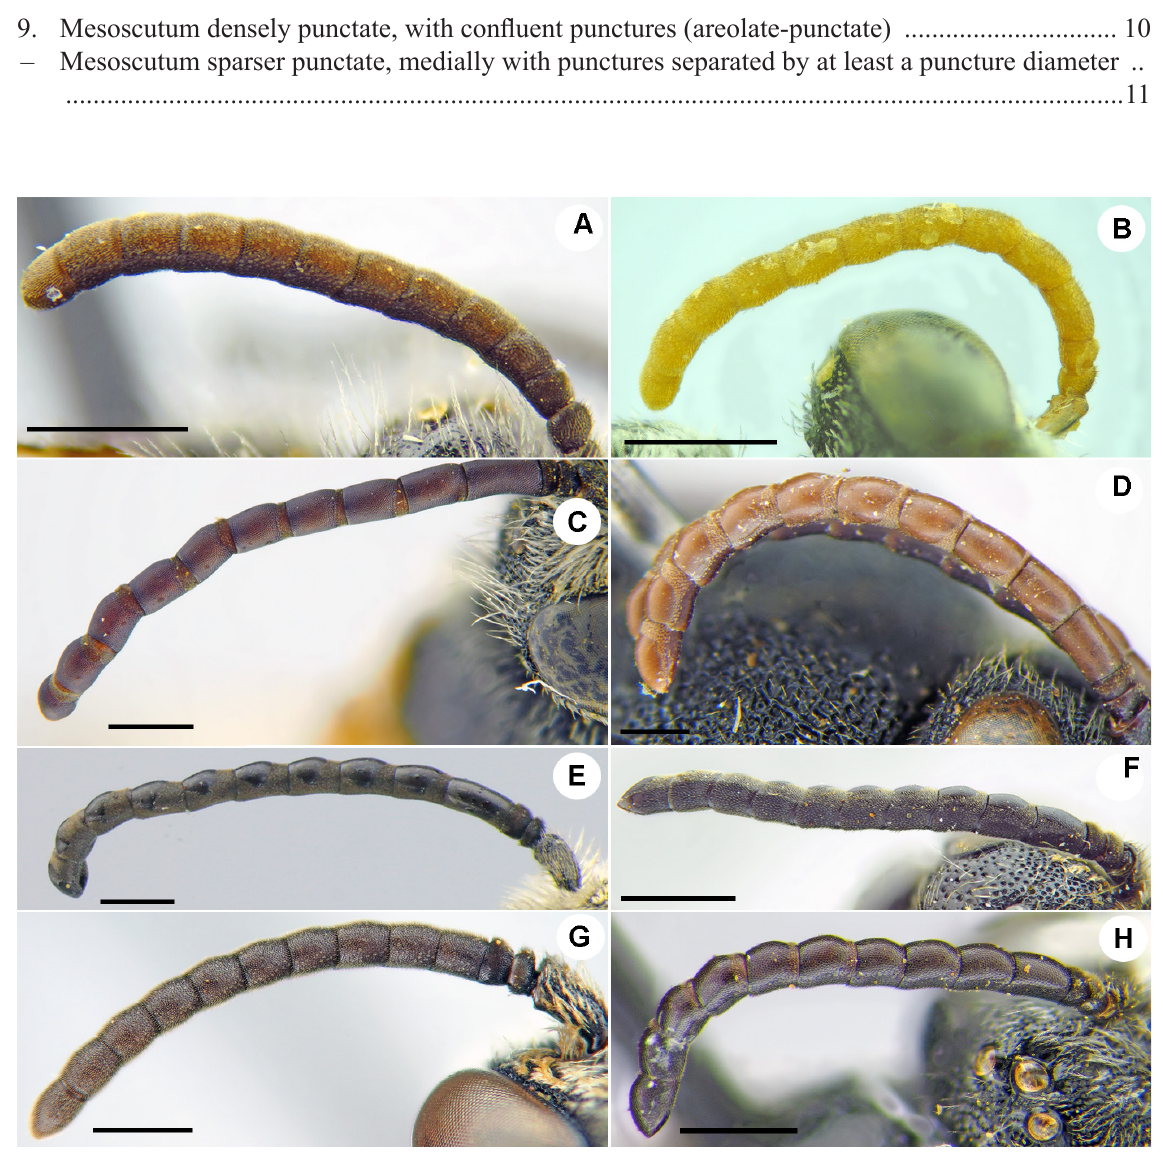
Fig. 2. Antennae in lateral view, males. A . Sphecodes hakkariensis Warncke, 1992. B . S. cameronii 1758). F . S. rufiventris (Panzer, 1798). G . S. kershawi Perkins, 1921. H . S. turneri Cockerell, 1916. Scale bars = 0.5